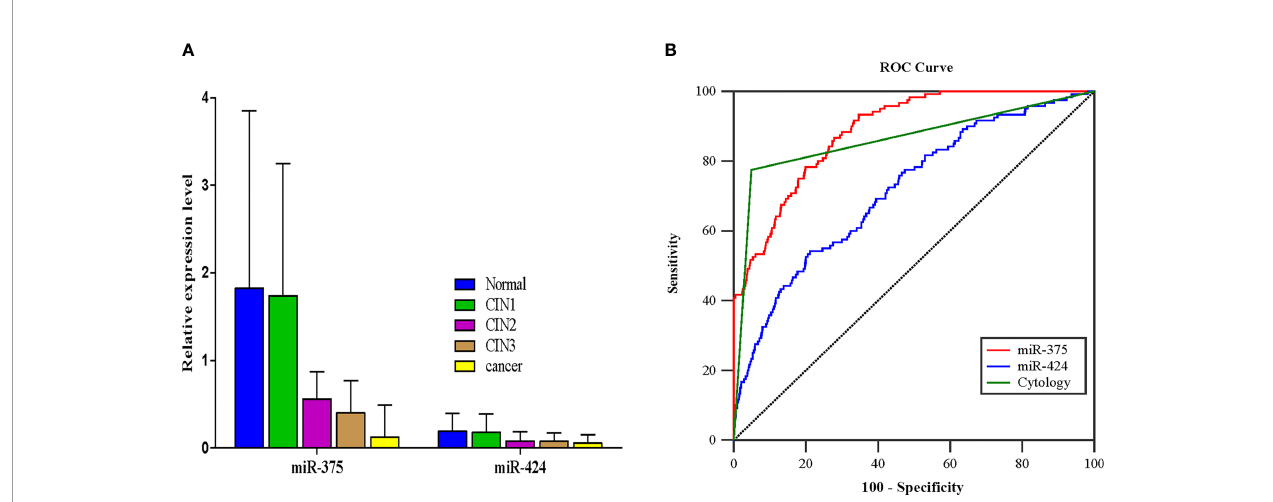
FIGURE 2 | The results of miR-375 and miR-424 detection and the determination of the cutoff value for identifying CIN2+. (A) The expression of miR-375 and miR- 424 in different pathological results, median (IQR) ( P < 0.001, P < 0.001). (B) The receiver operating characteristic curves of miRNA detection and cytology ( ≥ ASC- US) for identifying CIN2+.